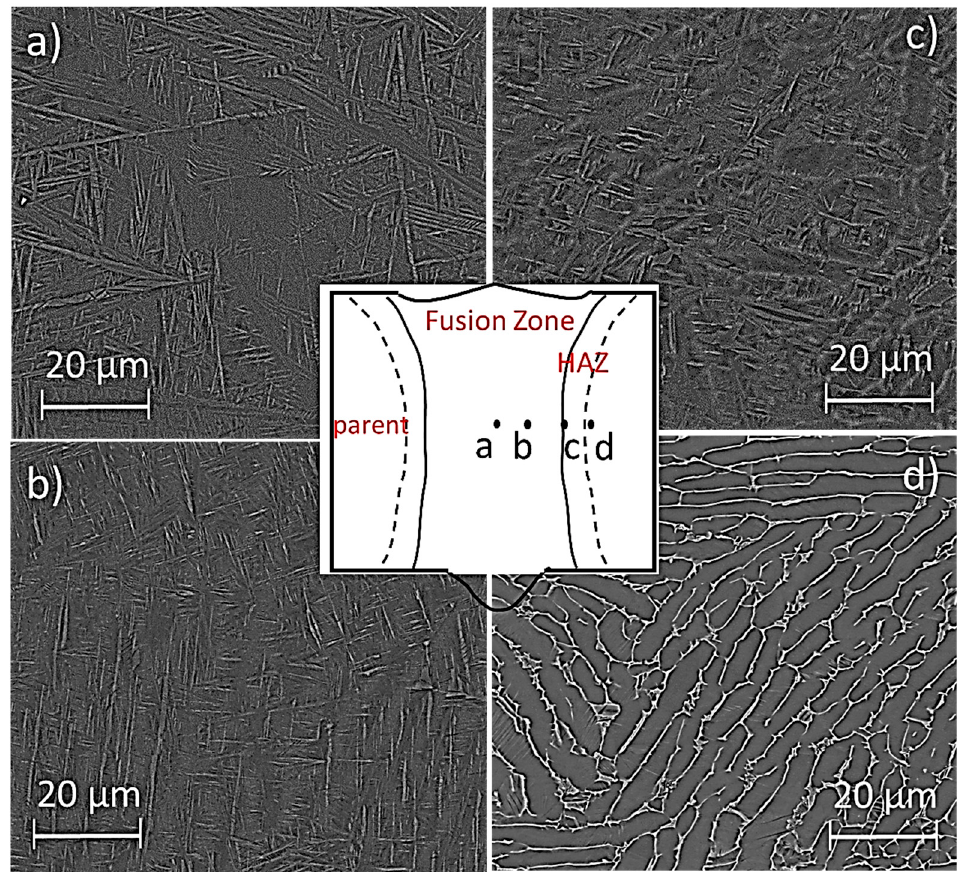
Figure 7 . Backscattered SEM images of weld e: 3.8-mm-thick plate with a lamellar morphology welded at 2 m min − 1 and 2.8 kW for locations ( a – d ) shown.